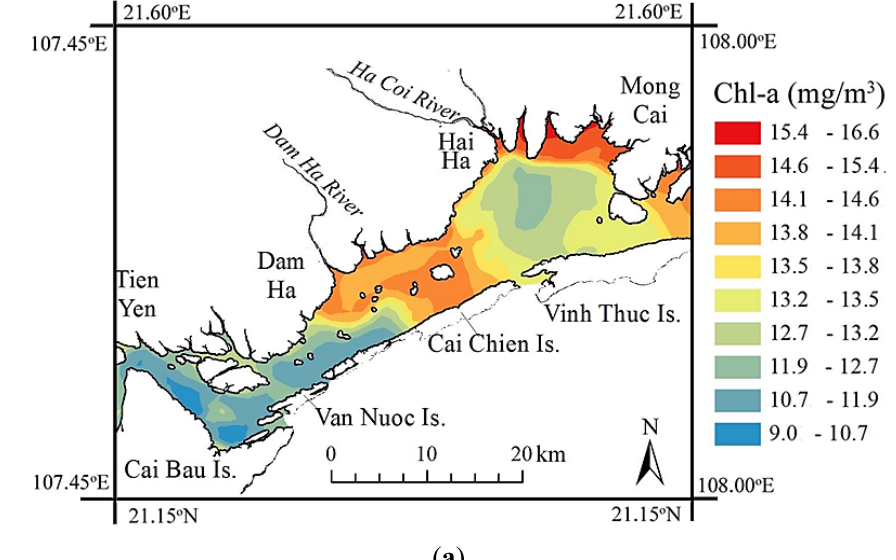
Figure 7. ( a ) Spatial distribution of Chl-a concentrations produced by interpolating the MODIS image-based estimation in Figure 4 using OK and a 100-m grid size. ( b ) Kriging variance for representing the uncertainty of estimation of Chl-a concentrations by OK. in the image, no space before and after en dash representing